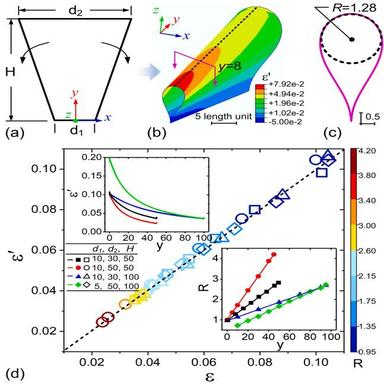
Finite element (FE) results indicating that is valid for the asymmetrical bending strategy. a) Geometrical model for bending simulation. Two unparallel edges were bent along with the y axis. b) Shape after bending. Two different bending radii form at the two free sides of the bent part with nonuniform actual strain on the upper film (R1<R2). c) Curved cross section at the position of y=8. The local bending radius R=1.28 can be estimated by fitting the curve with a circle. d) Relationship between